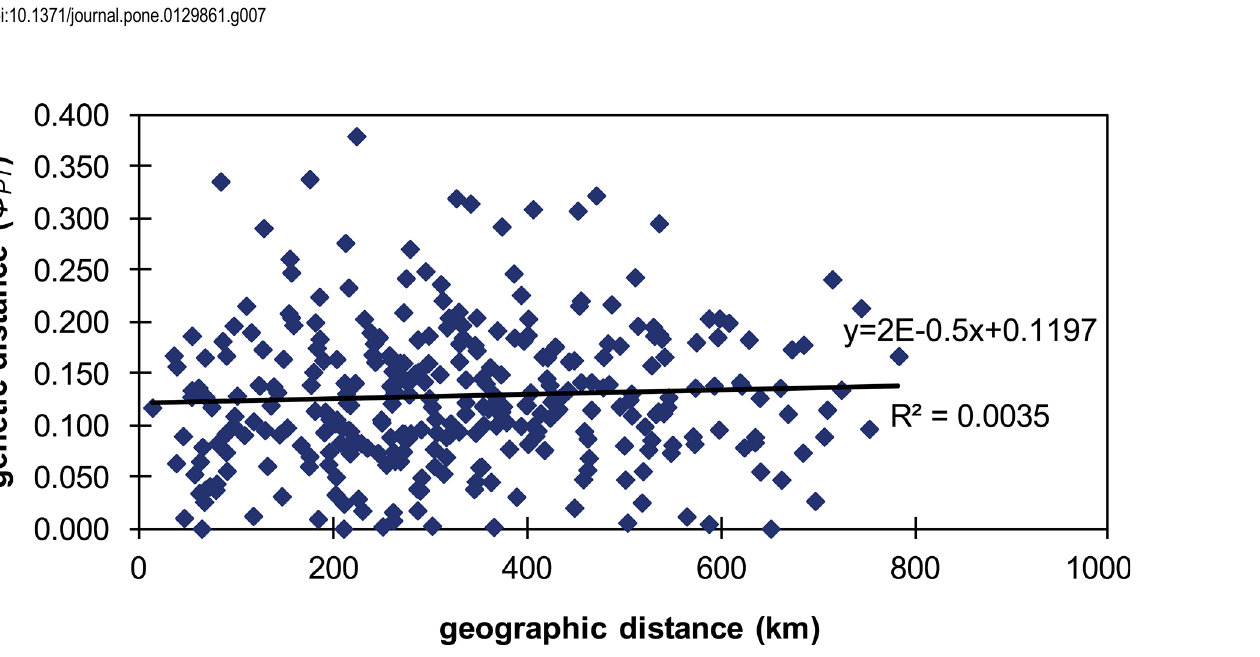
PLOS ONE | DOI:10.1371/journal.pone.0129861 June 19,